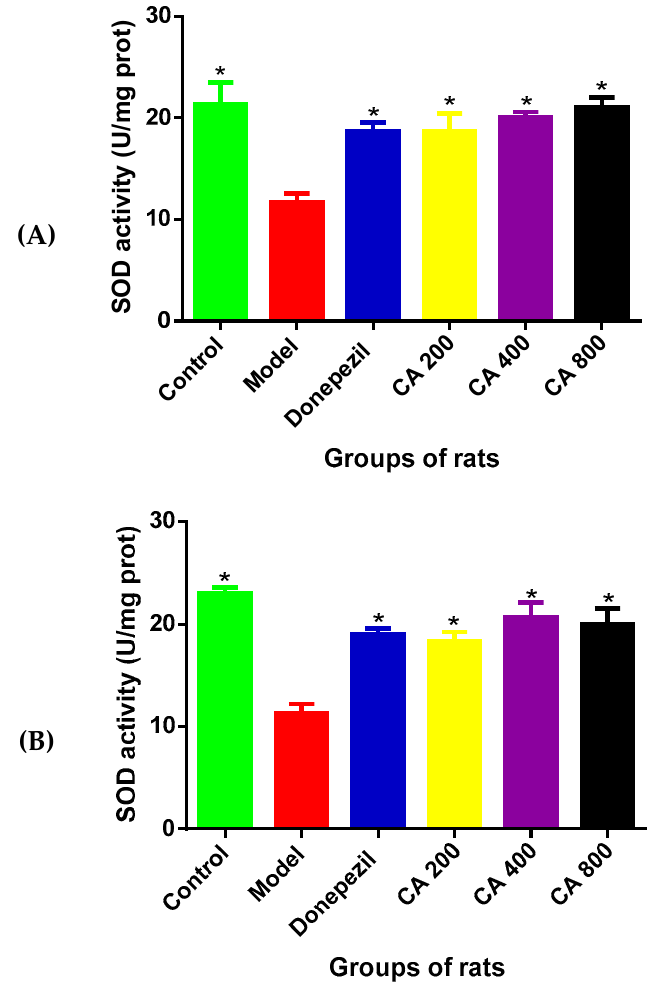
Figure 5. Effects of CA on superoxide dismutase (SOD) activities in the hippocampus and cerebral cortex of D-gal- and AlCl 3 -induced rats. ( A ) Hippocampus, ( B ) cerebral cortex. Values are presented as mean ± SEM, n = 3. * p < 0.05 vs. model group, # p < 0.05 vs. control group.